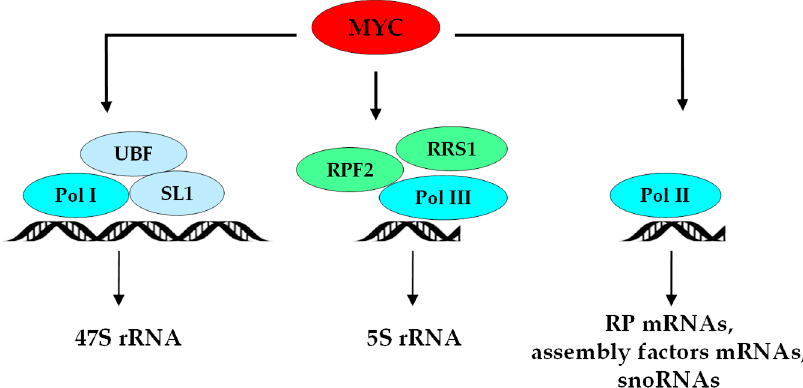
Figure 1. Regulation of early transcriptional steps of ribosome biogenesis in CRC. MYC is overexpressed in colorectal tumor cells, binds to rDNA sequences, and in cooperation with UBF and SL1 factors, leads to the hyperactivation of RNA pol I-mediated synthesis of the 47S rRNA precursor [84]. MYC, in cooperation with RPF2 and RRS1, activates RNA pol II-mediated transcription of genes coding for ribosomal assembly factors and RPs, as well as RNA pol III-mediated synthesis of 5S rRNA [57]. Overexpression of the three rRNA polymerases and the associated factors is frequent in CRC [80–83]. Together with RPF2 (protein ribosome production factor 2 homolog), RRS1 cooperates with POL III and drives 5S rRNA synthesis, while POL II activates ribosomal proteins and assembly factors mRNAs and snoRNAs synthesis.